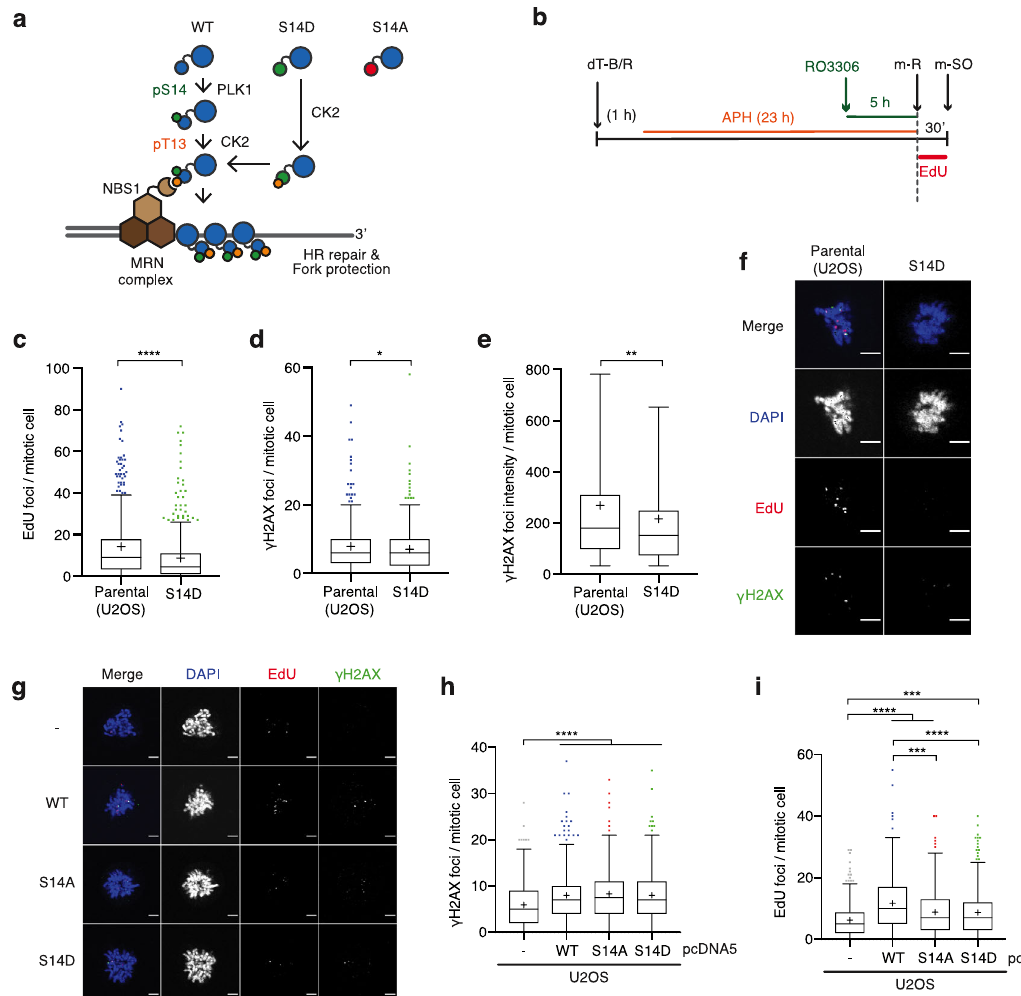
Fig. 4 PLK1-dependent RAD51 phosphorylation promotes non-DDR-associated MiDAS. a Schematic illustration of the mechanism recruiting RAD51 to sites of DNA damage via PLK1-dependent RAD51 S14 phosphorylation, triggering CK2-dependent RAD51 phosphorylation at T13, which mediates NBS1 interaction. b Schematic diagram of experimental procedure used to obtain data in Fig. 4c – i and Supplementary Fig. 5c – e. c – e EdU incorporation and γ